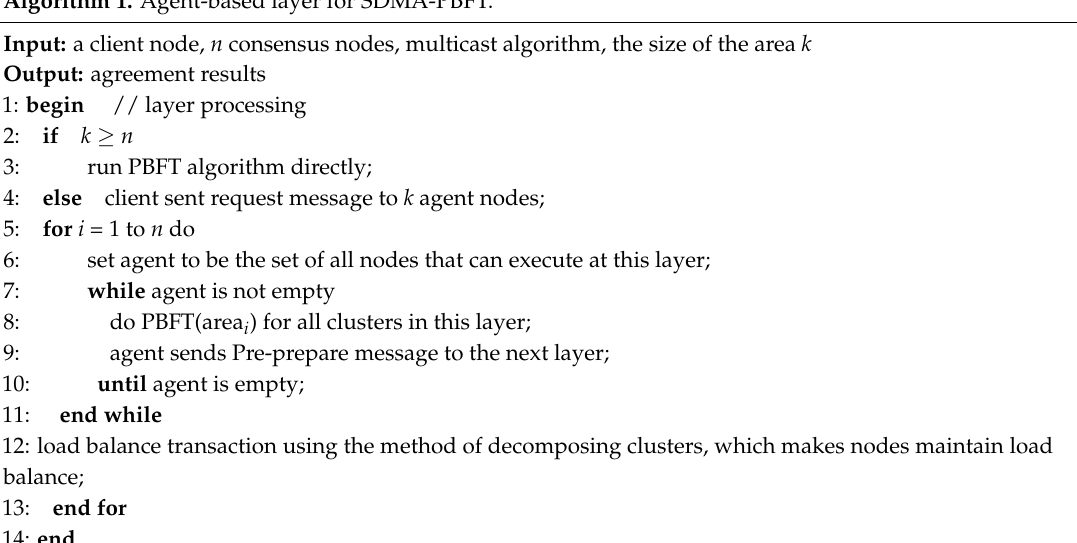
Figure 4. Spanning tree that is generated for multicasting. Then, we present a multicast algorithm that meets the PBFT conditions in the multicast application. The detailed algorithm is presented as Algorithm 2.